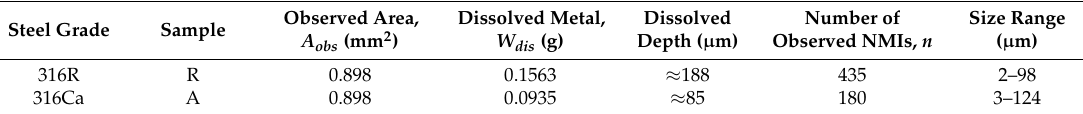
Table 2. Main parameters of the electrolytic extractions and SEM investigations of non-metallic inclusions (NMIs) in different